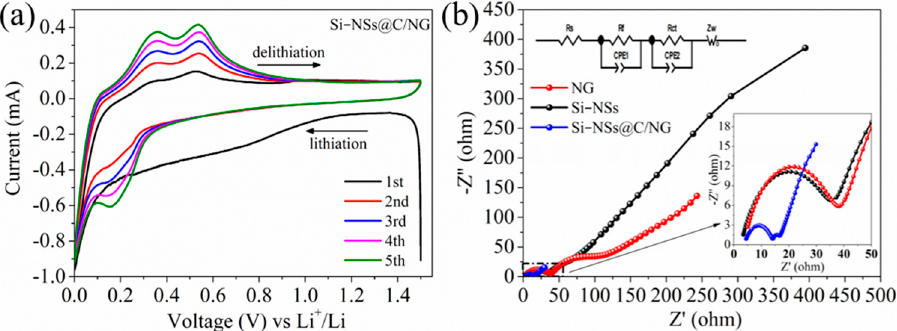
Figure 5. ( a ) CV curves of Si–NSs@C/NG at a scan rate of 0.25 mV s − 1 ; ( b ) Nyquist plot and corre- sponding equivalent circuit model of Si–NSs, NG, and Si–NSs@C/NG.